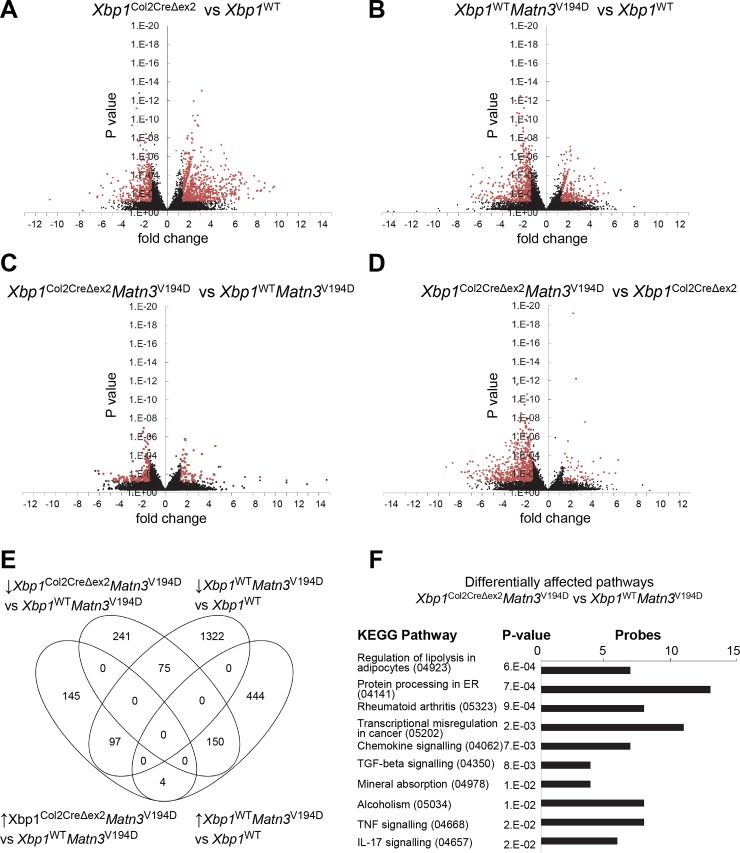
(A-D) Volcano plots of differential gene expression (in black) highlighting the significantly changed genes (1.5 fold, P<0.05; in red). (E) A Venn diagram comparing the significantly differentially expressed genes in the original EDM5 (Xbp1WT
Matn3V194D vs Xbp1WT
Matn3WT) model and the effect of XBP1 deletion (Xbp1Col2CreΔex2
Matn3V194D vs Xbp1WT
Matn3V194D). (F) Pathway analysis of the Xbp1Col2CreΔex2
Matn3V194D vs Xbp1WT
Matn3V194D microarray data was performed using the iPathwayGuide platform (Advaita Corp). Differentially expressed KEGG pathways are plotted using the P-values and the number of differentially expressed probes.